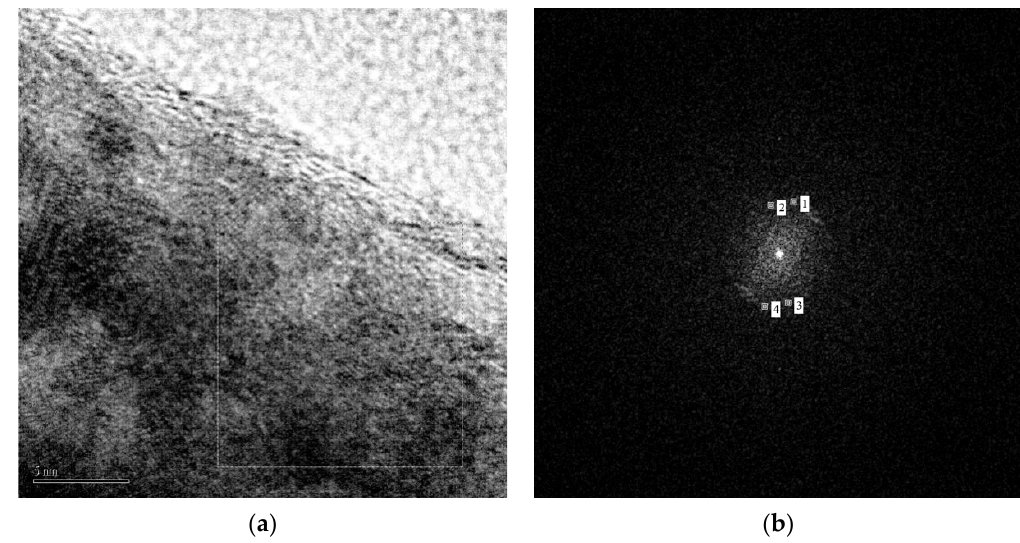
Figure 9. HR-TEM image of a nanowire produced on the B-Sn annealed powder sample: ( a ) high-resolution image; ( b ) diffractogram of selected zone.